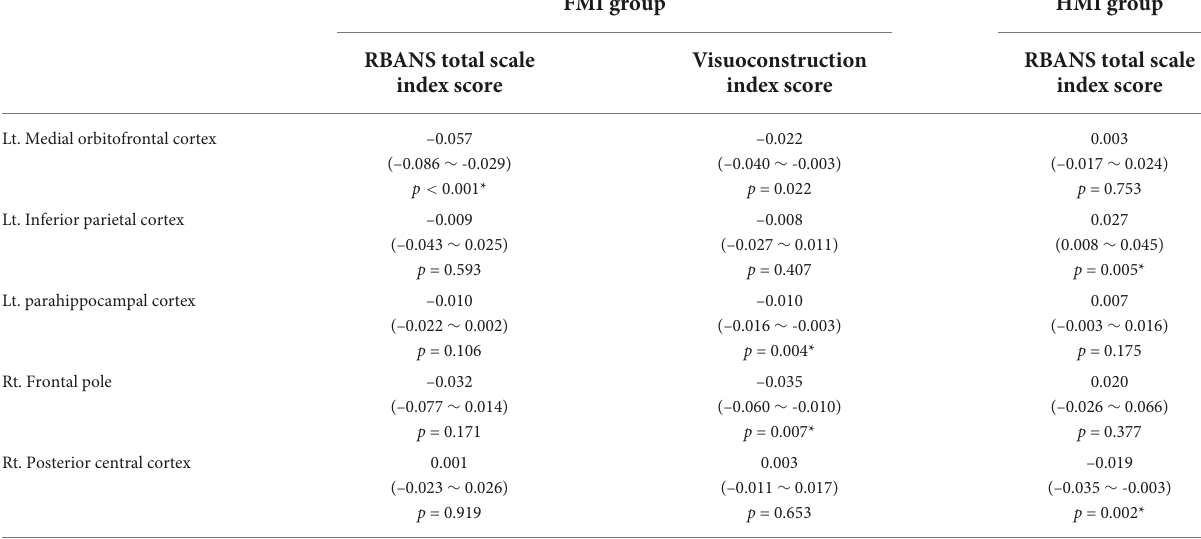
TABLE 4 Associations between changes in the characteristic path length of alpha1 band and changes in the Repeatable Battery for the Assessment of Neuropsychological Status in each intervention